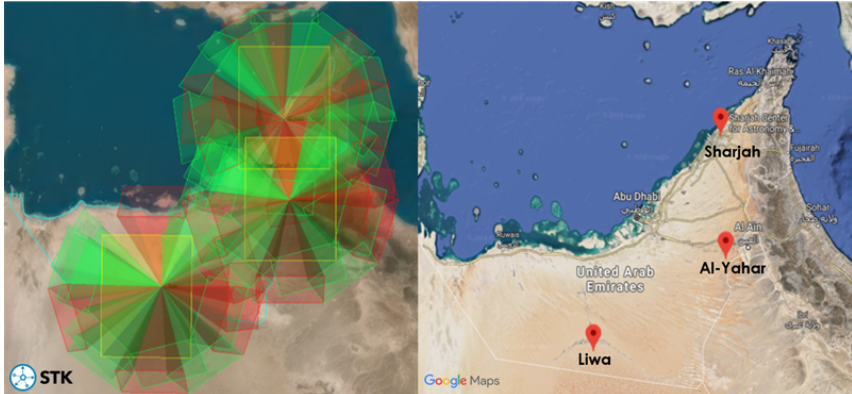
Figure 1. (a) Sky coverage simulation by all cameras using Systems Tool Kit (STK). (b) Location of the towers pinpointed on the UAE map using © Google Maps. Table 1. Location of the instruments used to generate data for this study. Instruments Geographical lat Geographical long Specification Sharjah Digital Ionosonde 25.285381 ◦ N Freq. range = 1–30MHz Sharjah Meteor Monitoring Tower Al-Yahar Meteor Monitoring